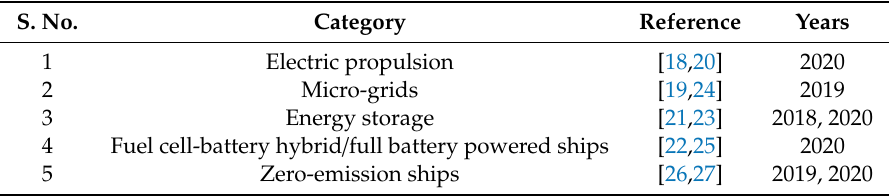
Table 1. Classification of review surveys on various aspects of green